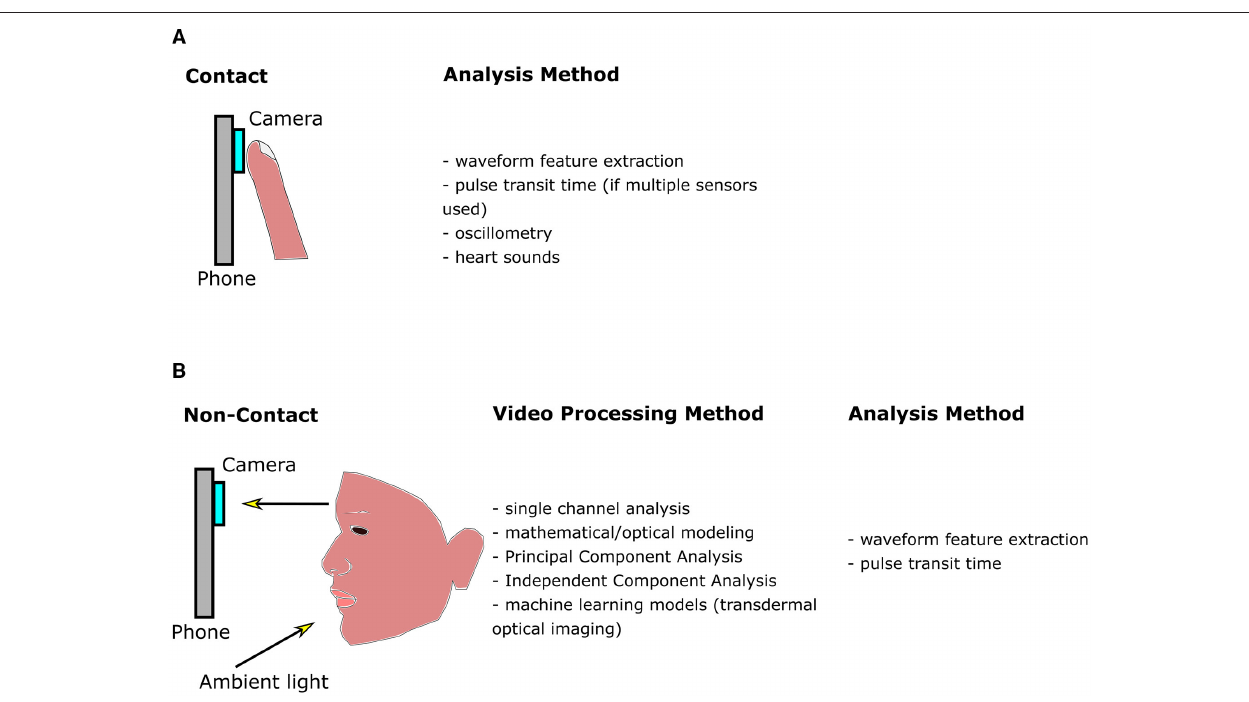
FIGURE 1 | Diagram outlining methods for smartphone blood pressure (BP) estimation. (A) Contact methods, which require pressing the finger against the phone camera to obtain a finger blood volume pulse. Pixels within the video are averaged in each frame. The signal may be further processed and filtered, producing a waveform as a function of time. Features are extracted from the waveform and input into machine learning algorithms to calculate BP. Pulse transit time (PTT) may also be correlated with BP, however multiple sensors are required. (B) Non-contact methods utilize ambient light reflected from the face. The resulting video is processed to enhance the signal-to-noise ratio of the hemoglobin signal, whose features are be input into a machine learning algorithm to calculate BP (similar to contact methods). Since multiple facial regions or body parts may be imaged simultaneously, PTT may be estimated using only a single camera by estimating the difference between pulse arrival at different body